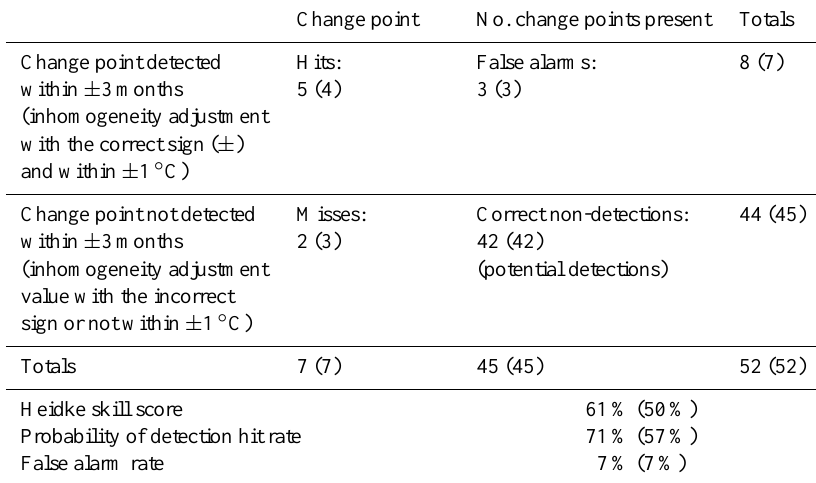
Table 2. Example contingency table for assessing change-point location detection and inhomogeneity adjustment skill (option shown in brackets) of homogenisation algorithms. Potential detections are the number of potential change points within the time period minus the total number of detections and misses. These are used to quantify those occasions where no change point is found and none is present. One way to do this is to assume that there is potentially a maximum of 1 change point every 6 months (some algorithms can only search for change points with 6 months of data on either side) such that a 26-year period will have 52 potential change